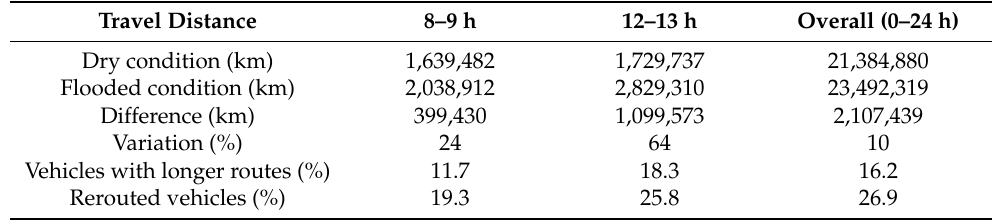
Table 5. Flood effects on travel distance.